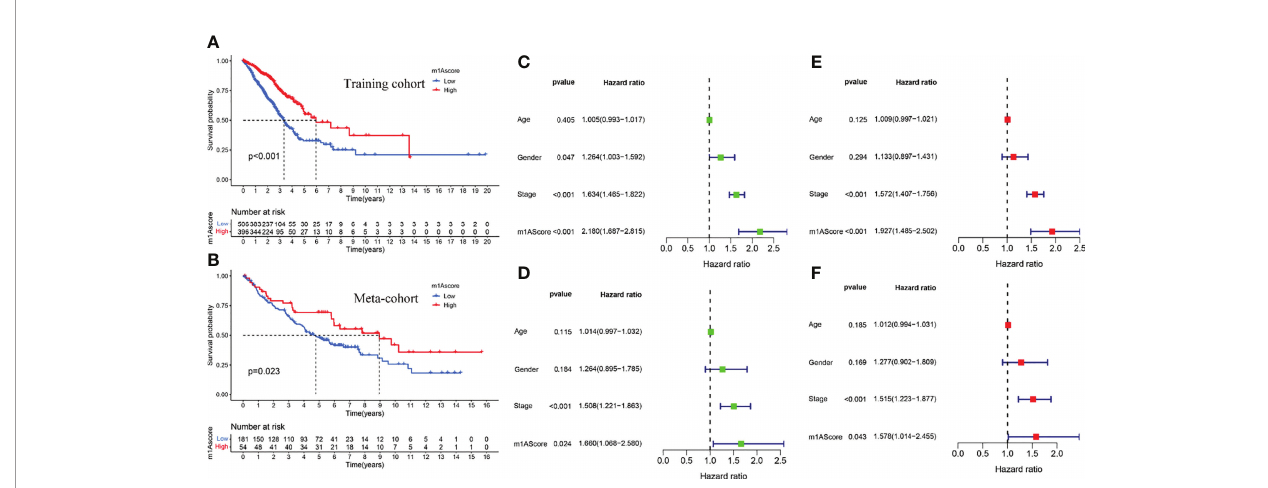
FIGURE 6 | Construction of m1A score and validation. (A) Survival outcomes prediction of the m1A score in the training cohort. (B) Survival outcomes prediction of the m1A score in the meta-cohort. (C, E) Univariate and multivariate analyses revealed the prognostic value of m1A score in the training cohort. (D, F) Univariate and multivariate analyses revealed the prognostic value of m1A score in the meta cohort.